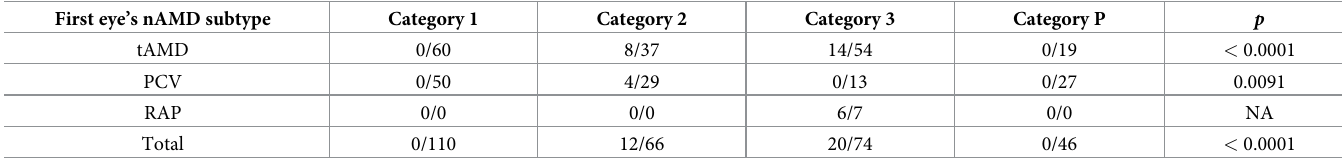
The occurrence of nAMD was analyzed by Fisher’s exact